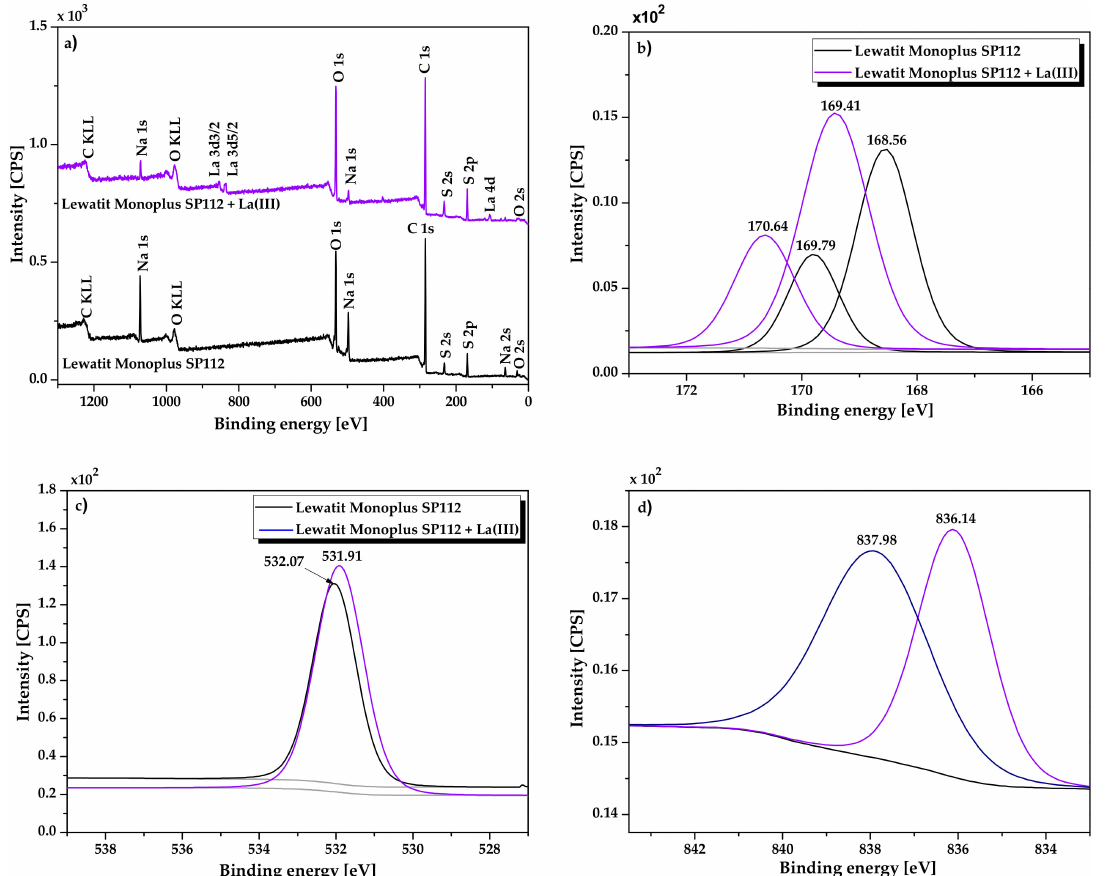
Figure 2. XPS spectra of Lewatit Monoplus SP112 before and after La(III) loading: ( a ) survey, ( b ) S 2p, ( c ) O 1s, and ( d ) La